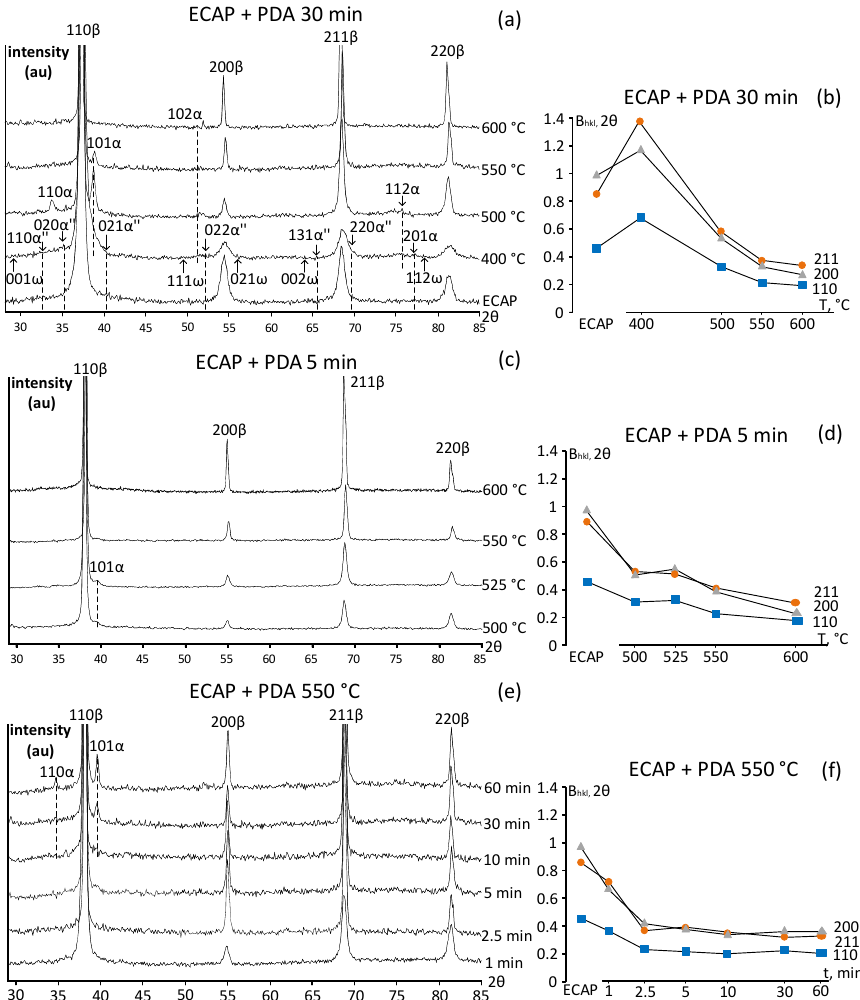
Figure 2. Results of the XRD analysis of Ti ‐ 18Zr ‐ 15Nb alloy after: (( a , b ) ECAP + PDA 30 min; ( c , d )) ECAP + PDA 5 min; ( e , f ) ECAP + PDA 550 °C; ( a , c , e ) X ‐ ray diffractograms; ( b , d , f ) changes in the {110} β ‐ phase X ‐ ray line width.